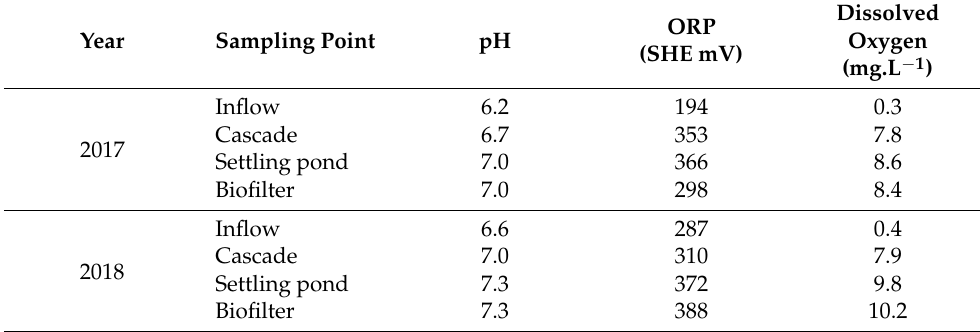
Table 2. Water chemistry in the Lop é rec mine drainage treatment